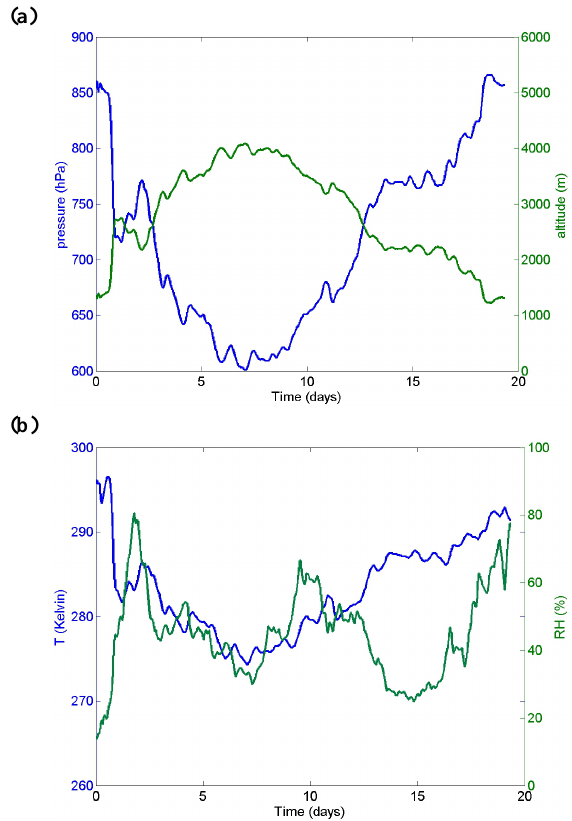
Fig. 8. (a) Time sequences of the atmospheric pressure and pressure altitude of the air parcel intercepted by the Falcon on 13 August at 3900m for the entire simulation period of 20 days (4-24 August). (b) Time sequences of temperature and relative